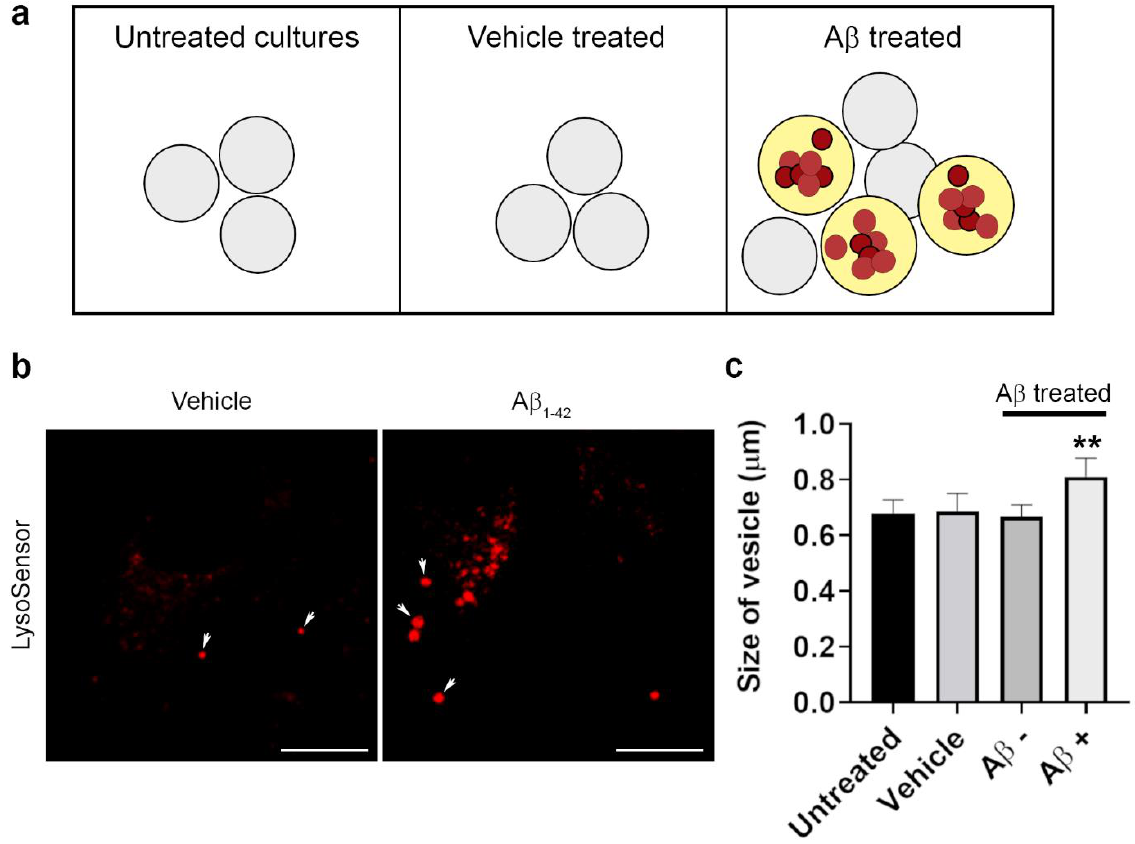
Figure 6. Effect of Aβ on RPE lysosomal size. ( a ) The diameter of LysoSensor-positive vesicles was quantified in RPE cells that were untreated, treated with vehicle or human Aβ 1-42 , 24 h after Aβ exposure. ( b , c ) Results show a significant increase in vesicle dimeter in compartments containing Aβ compared to those in the same cell without Aβ cargo or in vehicle-treated or untreated RPE cells. Scale bars in b correspond to 10 μm. The 25 vesicles measured in six random images from three separate experiments per treatment group. A significance of p ˂ 0.01 (denoted by **) was observed when the size of Aβ-positive vesicles was compared to vesicle dimeters in all other conditions. One-way ANOVA with Tukey’s multiple comparisons test (F 3,20 = 8.73).